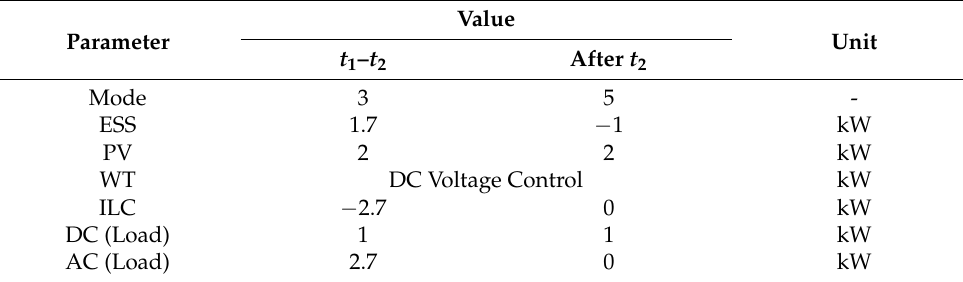
Table 7. Microgrid power flow (3) in